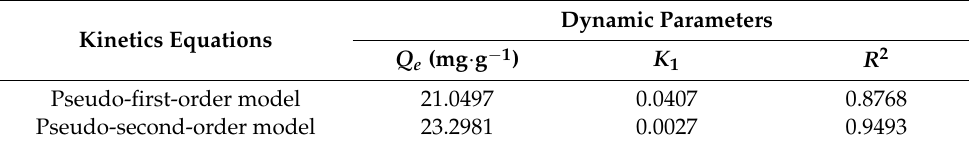
Table 2. Adsorption kinetics parameters for the TFC on the D-101